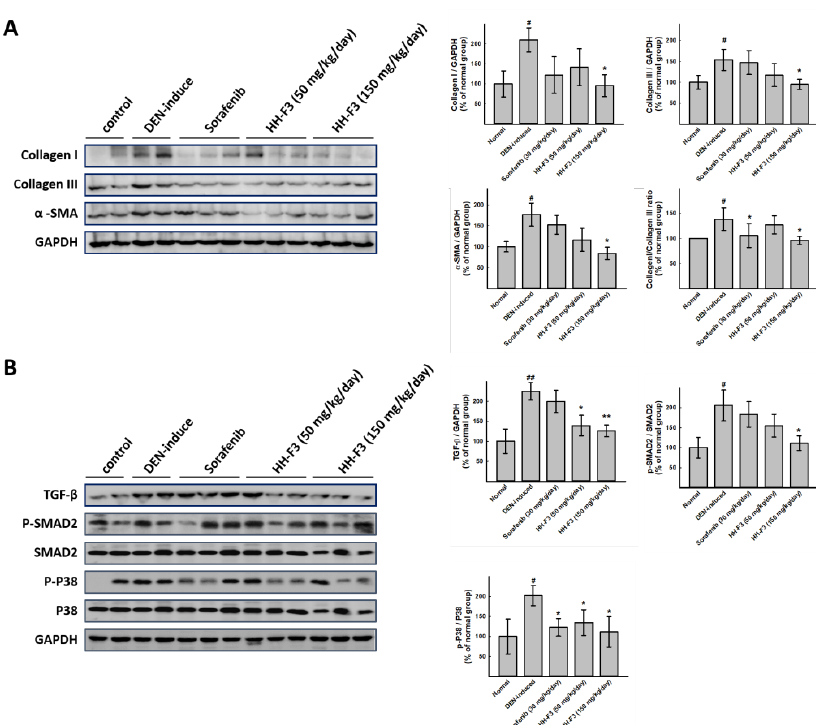
Figure 6. Effects of HH-F3 on fibrogenesis markers and the TGF-β pathway from the in vivo model. Rats were divided into five groups. One group served as the untreated control, one group was treated with DEN to induce liver fibrosis, and the other groups were cotreated with DEN and sorafenib or different doses of HH-F3 (50 mg/kg/day and 150 mg/kg/day) orally (oral administration, P.O.) every day. Rats were sacrificed and the liver tissues were homogenized followed by Western blot analysis and quantification. ( A ) HH-F3 reduced fibrogenesis markers in a DEN-induced liver fibrosis model. ( B ) HH-F3 inhibited the TGF-β pathway in a DEN-induced liver fibrosis model. * p < 0.05, ** p < 0.01 compared to the DEN group; # p < 0.05 compared to the normal group.